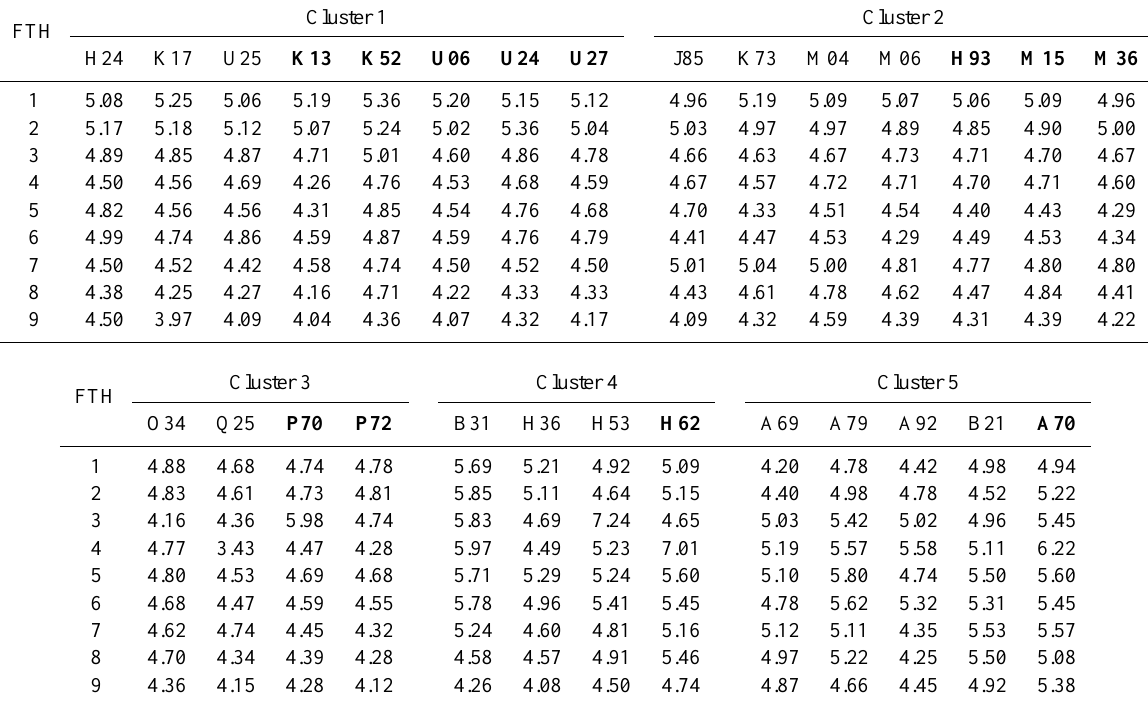
Table 3. Test based on the normalized sum in new catchments and different FTHs of regional integration given by the analysis of clusters by geographical location of the basin outlets. Values lower than 5 determined that the scores of selection are better than the reference set. See clusters’ distribution in Fig. 1. In each cluster, the catchments highlighted in bold represent the series that are not used by the hydrological members’ selection training